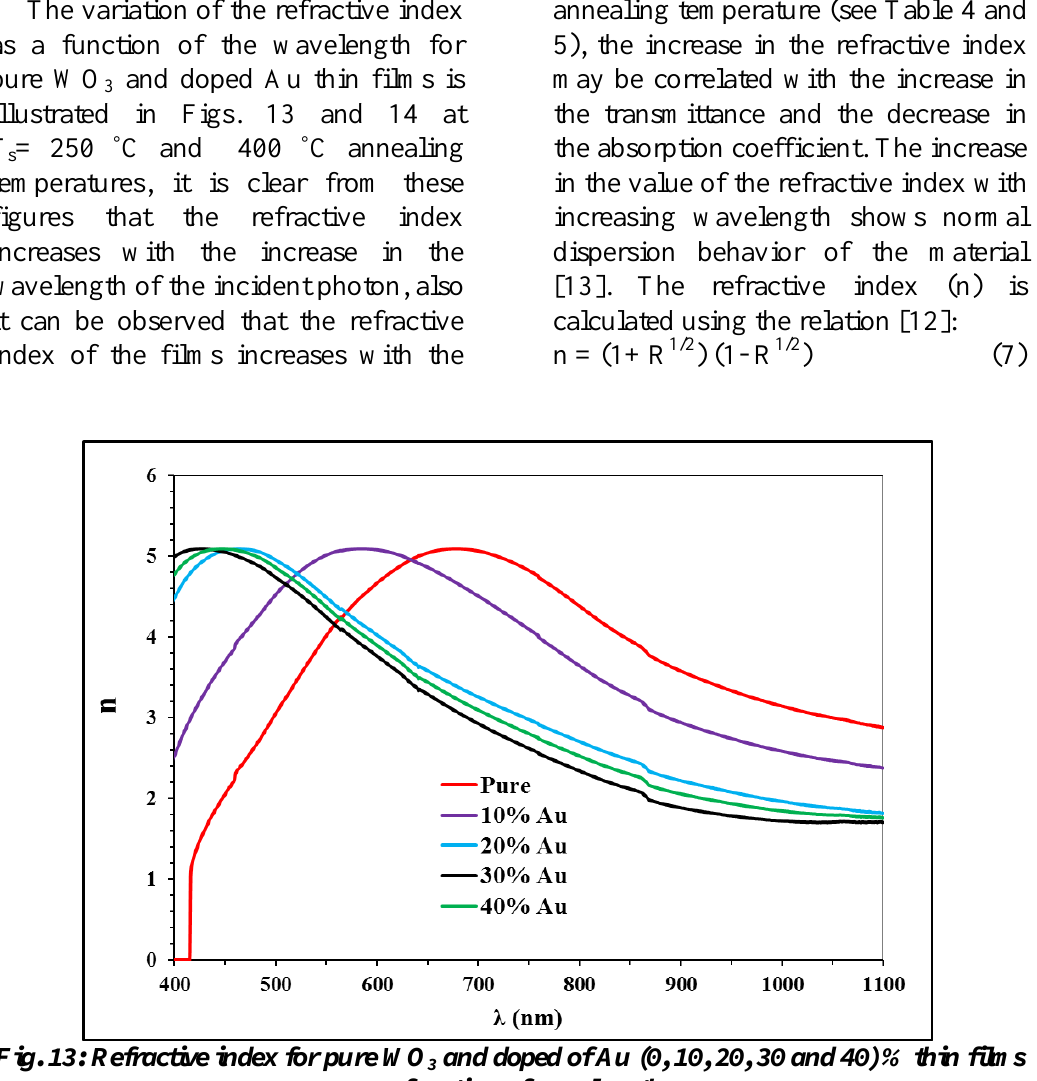
and doped of Au (0, 10, 20, 30 and 40) % thin films 3 as a function of wavelength.